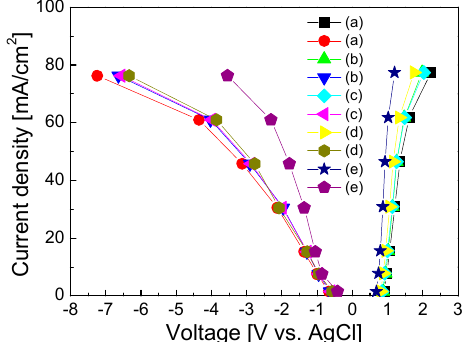
Figure 4. Dependence of the polarization curves on the concentration of the added water: (a) 0 M, (b) 1.1 M, (c) 5.0 M, (d) 9.3 M, and (e) 20.8 M.